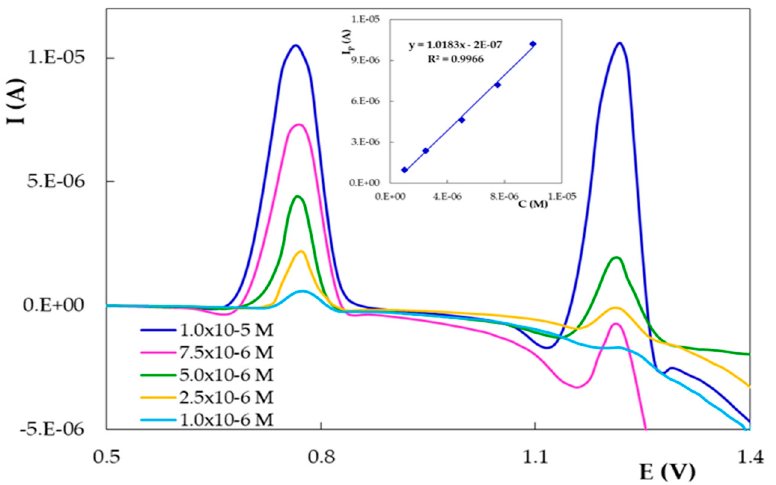
Figure 10. Differential pulse voltammograms recorded on PGE_H for different concentrations of DIO in 0.10 mol/L H 2 SO 4 . The inset shows the corresponding calibration curve. The linear range of one order of magnitude (1.00 × 10 − 6 to 1.00 × 10 − 5 mol/L DIO) obtained by DPV on PGE_H is sufficient for DIO quantification in dietary supplements, but for the analysis of real samples, e.g., citrus fruit parts and biological fluids, a more sensitive method is necessary. Therefore, the DIO adsorption properties on PGE, deduced from the previous CV studies, were investigated in order to exploit them for a more sensitive stripping voltammetric analysis. Consequently, the influence of the accumulation time and potential on DIO oxidation peak from about ~0.780 V was examined. DP voltammograms recorded after maintaining the PGE-H at 0.000 V in a 1 × 10 − 6 mol/L DIO solution (the lowest concentration of the linear range obtained by DPV) for different times (0–90 s) emphasized that the peak current increased with the accumulation time up to 60 s and remained constant for longer deposition periods (Figure 11) due to the saturation of the electrode surface with the analyte molecules.